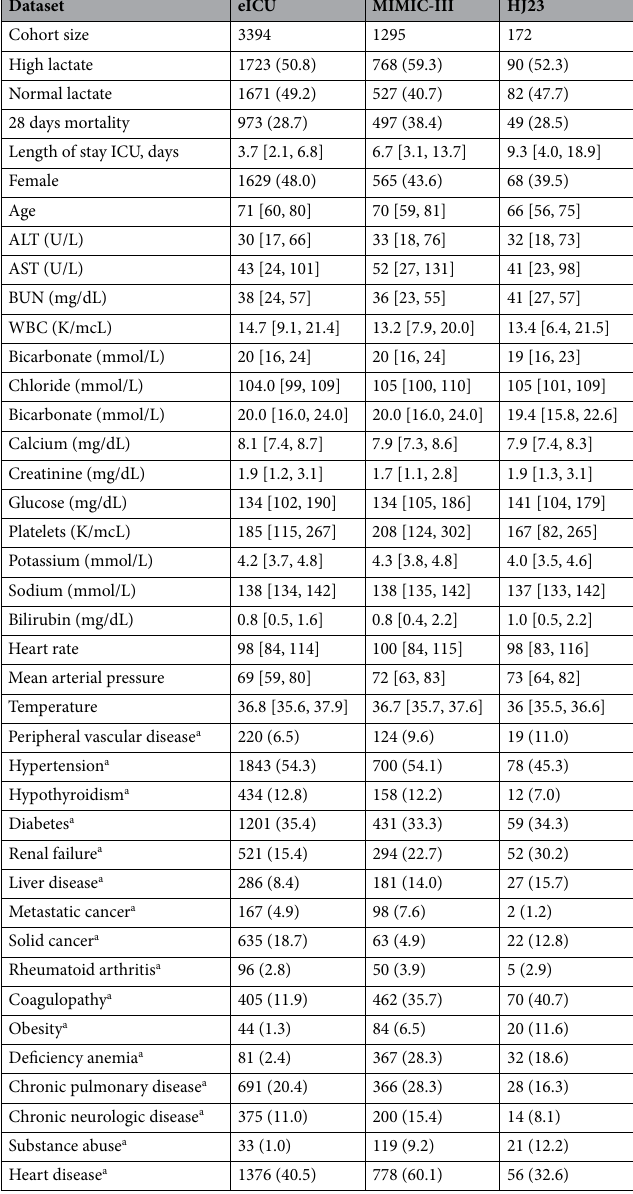
Table 1. Overview of baseline characteristics of patients from the three ICU datasets. Overall, characteristics are similar between datasets, with notable exceptions being a higher rate of renal failure, liver disease, and coagulopathy in HJ23. N (%), Median [IQR]. a Medical history as defined by ICD